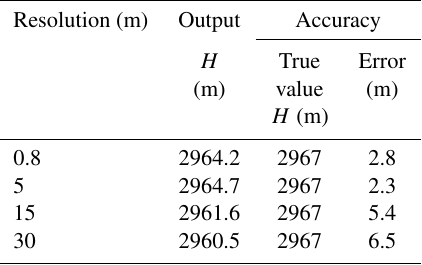
Table 5. Results predicted using images with different